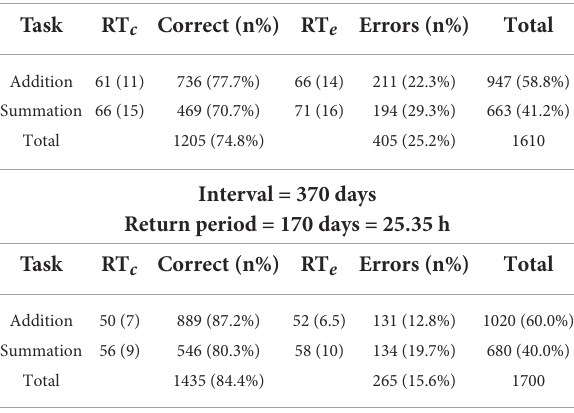
TABLE 2 Response time for addition and summation tasks subsetted by test